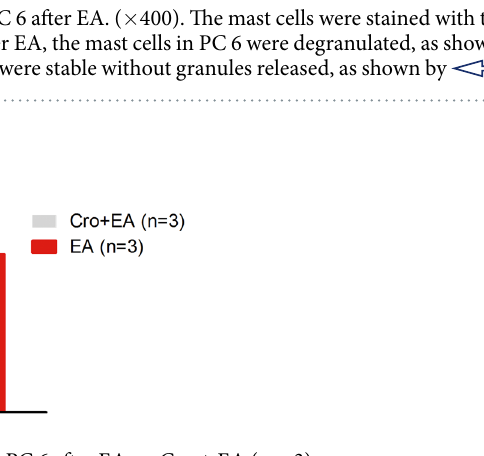
Figure 4. Degranulation ratios of mast cells in PC 6 after EA vs. Cro + EA (n =